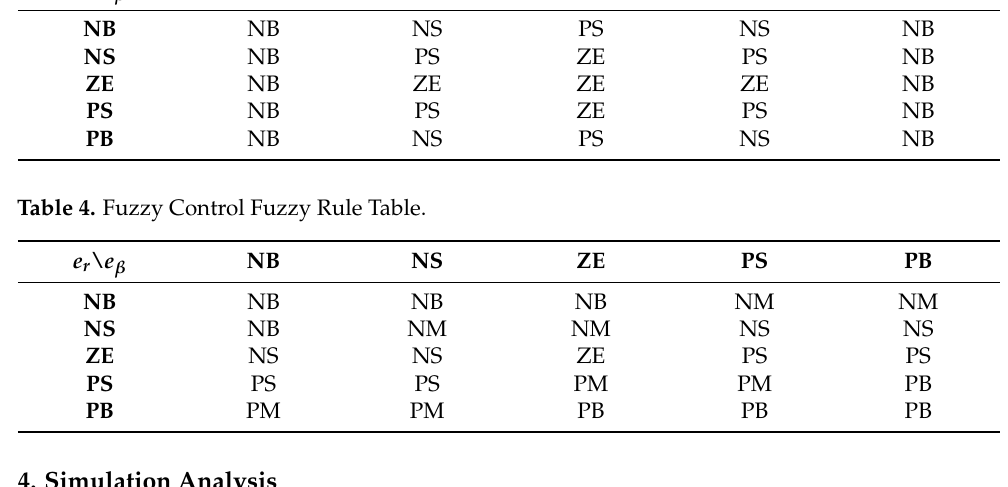
Figure 8. Membership function of the additional yaw moment.